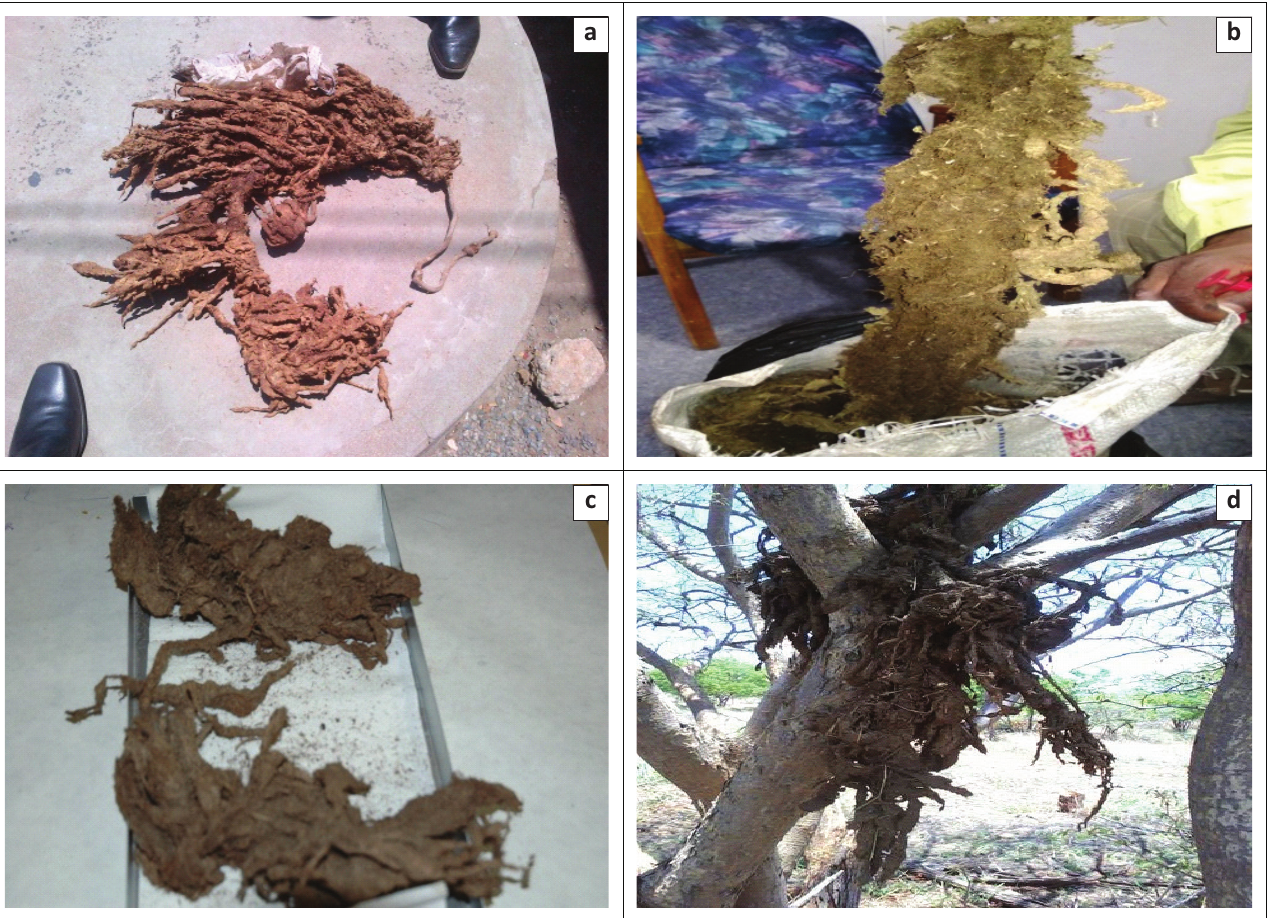
FIGURE 2: Photos of rumen impaction material at different time intervals post-sampling (a, c and d) the rumen, with (b) representing fresh impaction material as evidenced by greenish colouring.